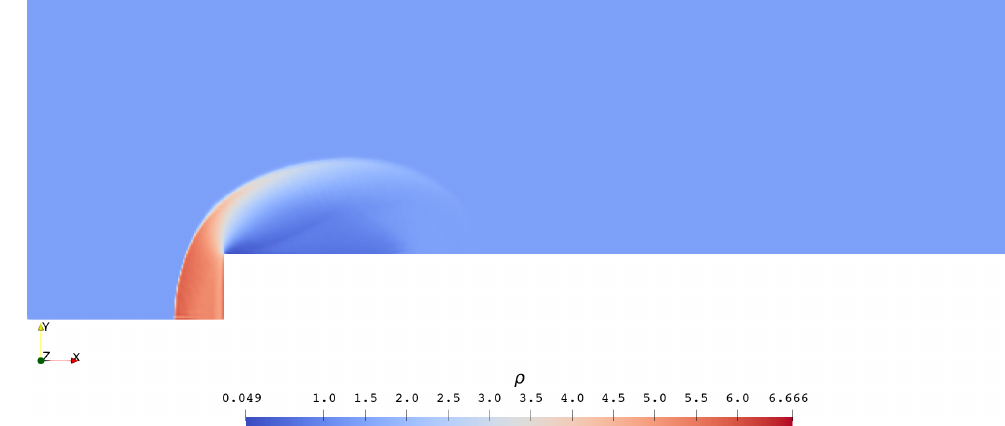
Figure 9. Third-order solution of Problem 4 at t = 0.2 on an h = 1/200 mesh.